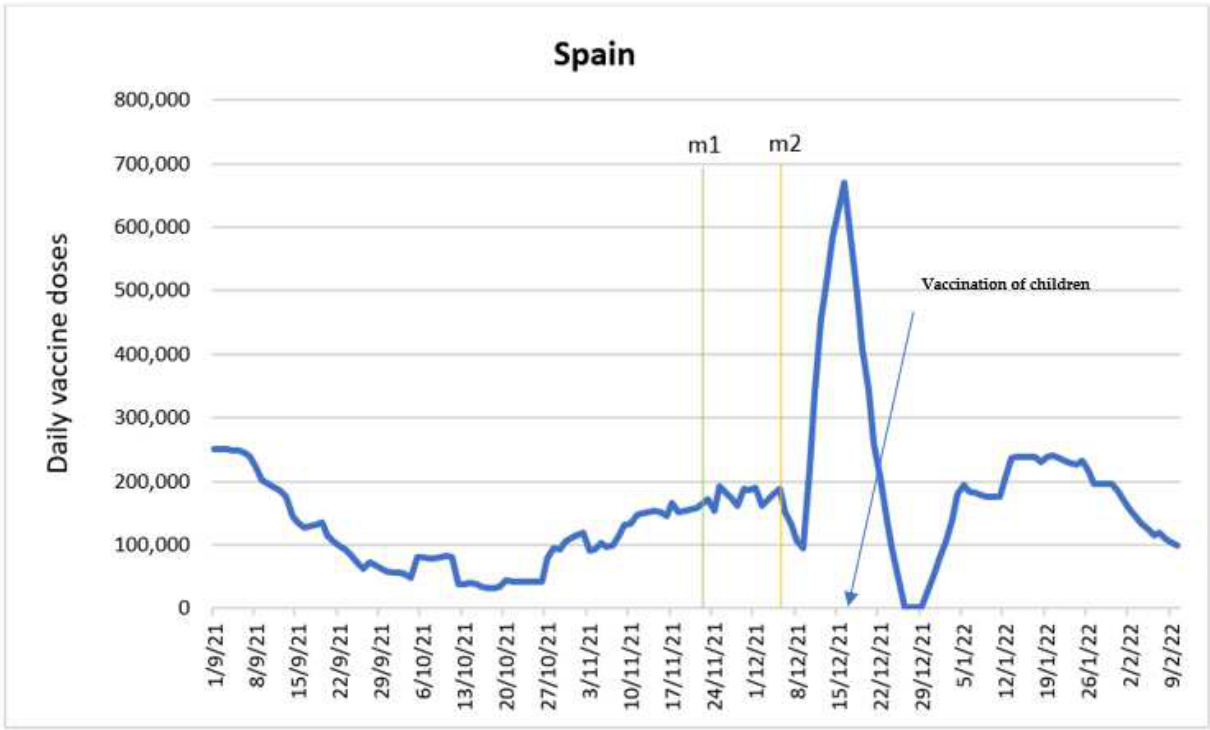
Figure 1. Daily new vaccinations in Austria before and after the policy changes and predicted values in absence of intervention based on ARIMA model. COVID certificates in